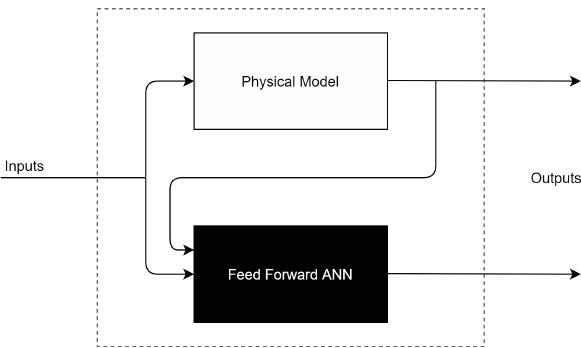
Figure 2. Combination of physical and black box